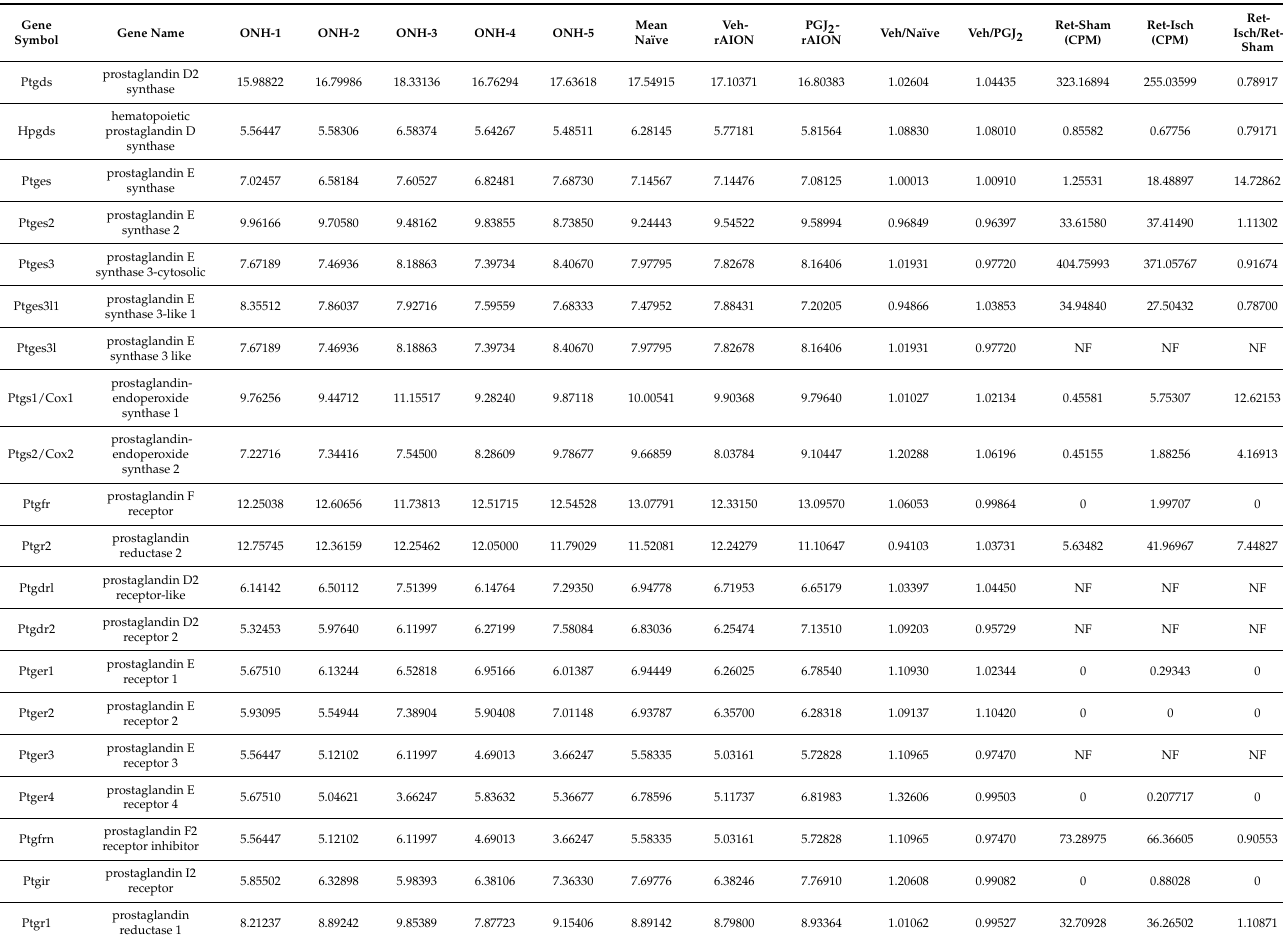
Table 2. Normalized mean relative expression of selected prostaglandin-synthetic and receptor-associated genes in rat ONH and retina. Illumina sequence data for ONH are based on Deseq2-normalized (log 2 -fold relative levels) expressed in ONH RNA from individual naïve, mean naïve ( n = 5), rAION-vehicle-induced and rAION-PGJ 2 -treated animals, using a cutoff of <3.4. Normalization is based on Trimmed Mean Values (TMM) and normalized by EdgeR-cpm function with a cutoff of 2. Naïve retina (retina-N) and ischemic retina (retina-Isch) are from [19] and expressed in counts per million (CPM). The ratio of expression in ischemic retina/sham retina values are shown in the last column. The main CNS-expressed form of prostaglandin D2 synthetic gene (PTGDS) which gives rise to PGJ 2 is expressed at extremely high levels in ONH, and in moderately high levels in retina, while the gene for microsomal PGE 2 synthesis (PTGES2) was higher in ONH than cytosolic PGE 2 synthesis (PTGES3), while this pattern was reversed in retina. There was no ONH expression of synthetic genes for either PGF 2 or PGI (prostacyclin). Genes for downstream prostaglandin H synthesis from arachidonic acid (COX1/PTGS1 and COX2/PTGS2) were expressed at moderately high levels in ONH, but at extremely low levels in the retina in both naïve and ischemic conditions. NF: not